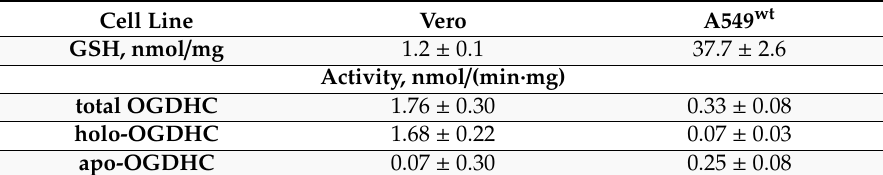
Table 2. Inverse relationship between the OGDHC activity and glutathione level, assayed in the Vero and A549 wt cell lines under control conditions. The data of at least three independent experiments are presented as means ±